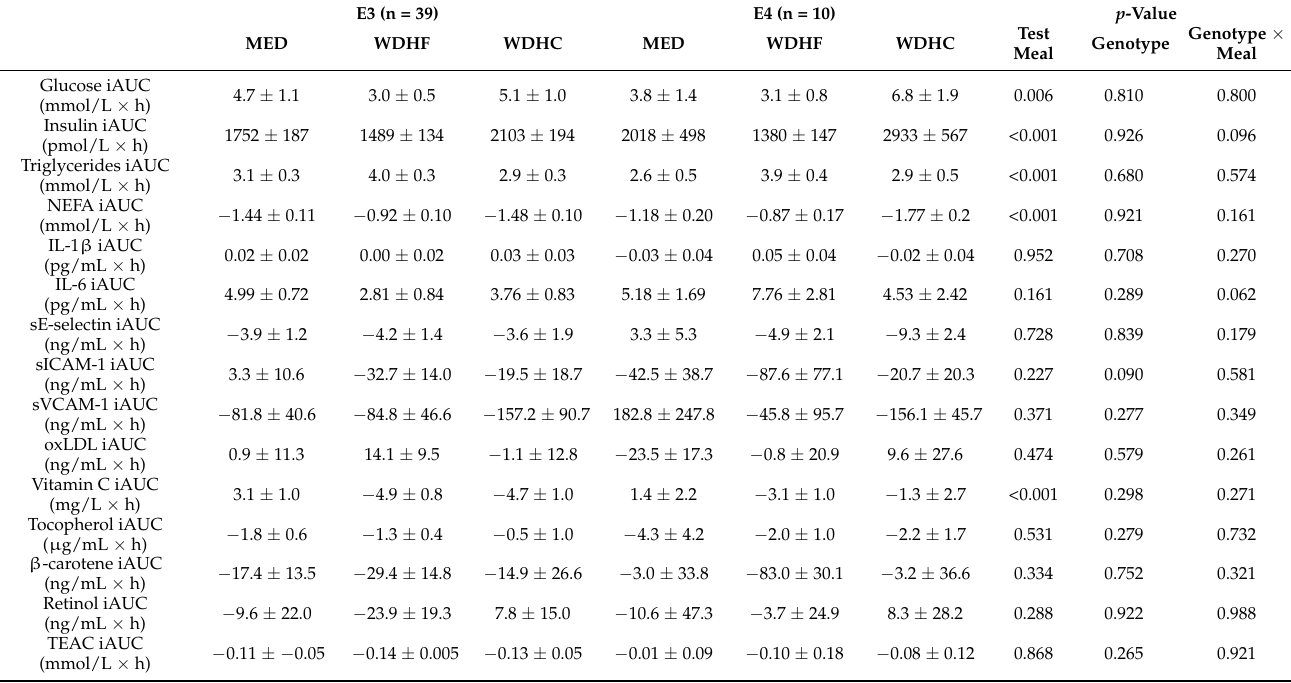
Table 3. Postprandial responses to three different test meals in high CVD risk participants classified by APOE genotype (E3 vs. E4), as indicated by incremental AUC (iAUC) values for parameters of lipid and glucose metabolism, biomarkers of inflammation, and antioxidant status 1